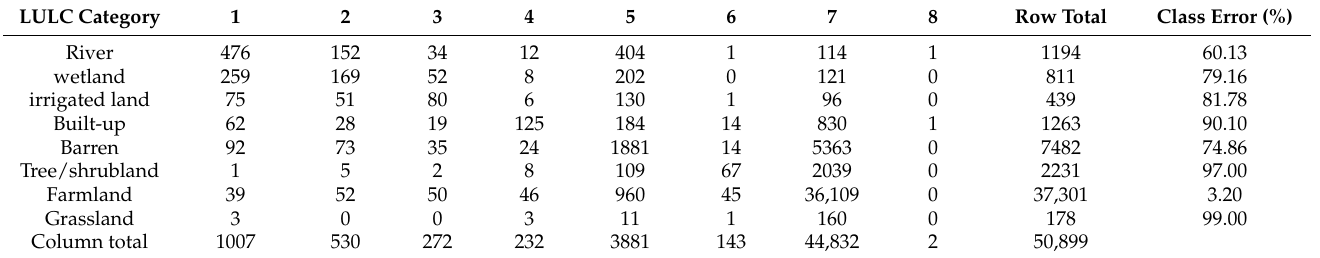
Table 4. OOB confusion matrix for SRTM data (Scenario 2) classification results.